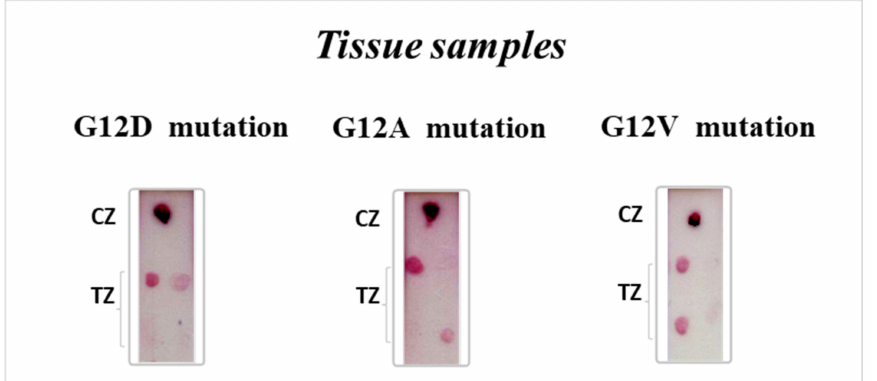
Figure 3. The multiplex strip test results of three tissue samples that have the G12D, G12A, and G12D KRAS mutations. TZ: test zone, CZ: control